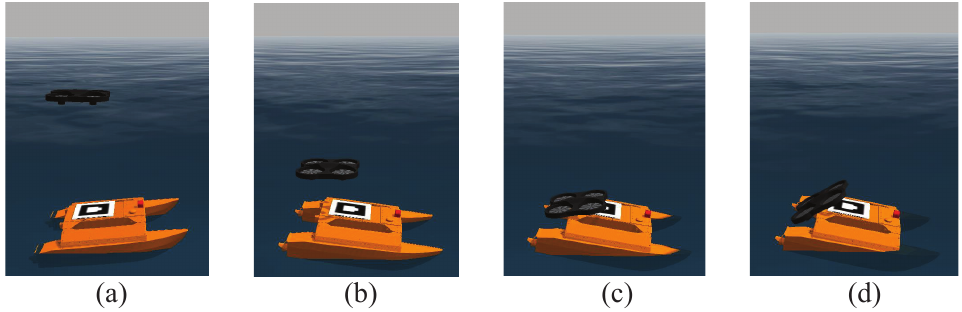
Figure 7. USV pitching motion − failure situation of UAV landing.The UAV did not respond to the attitude change of the USV, and the landing process was a vertical landing ( a – c ). When the USV pitch angle changed greatly, the UAV collided with the stern of the USV, resulting in the failure of the UAV landing ( c , d